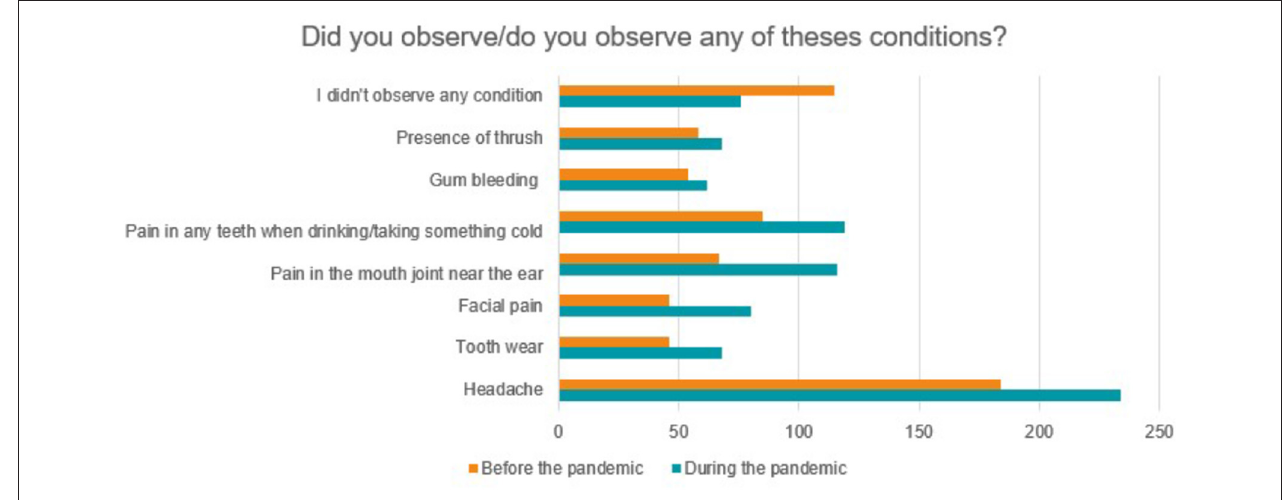
FIGURE 9 | Conditions observed before and during the pandemic.